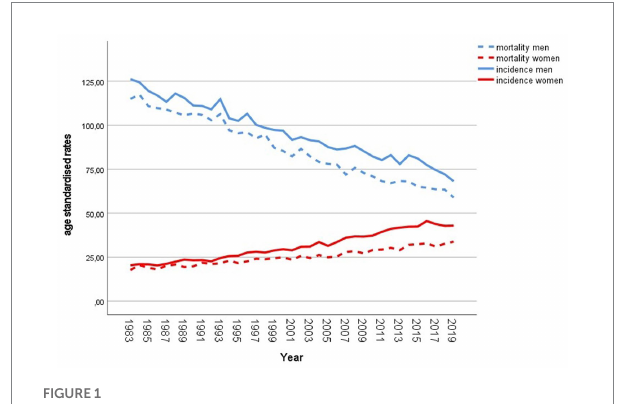
FIGURE 1 Incidence and mortality of lung cancer in Austria since 1983. Age standardized rates per 100,000 population, European Standard Population 2013. Source: Statistics Austria